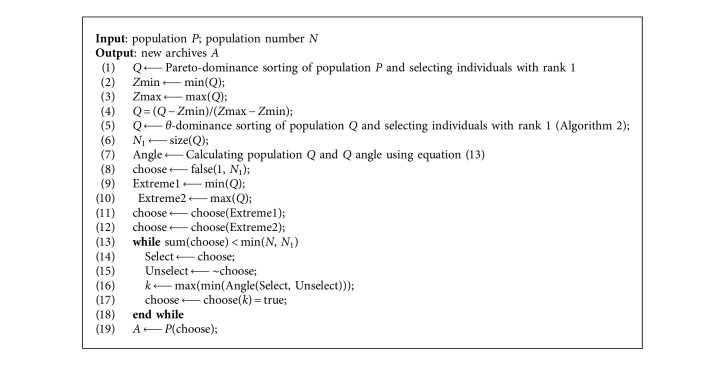
Archives updating.